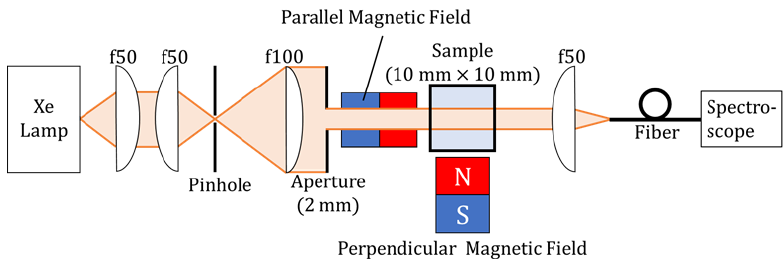
Figure 5. Optical system for measuring the change in the transmittance of the suspension of nickel coated hemispherical Janus particles. The magnetic field either parallel or perpendicular to the light propagation direction was applied to the sample.